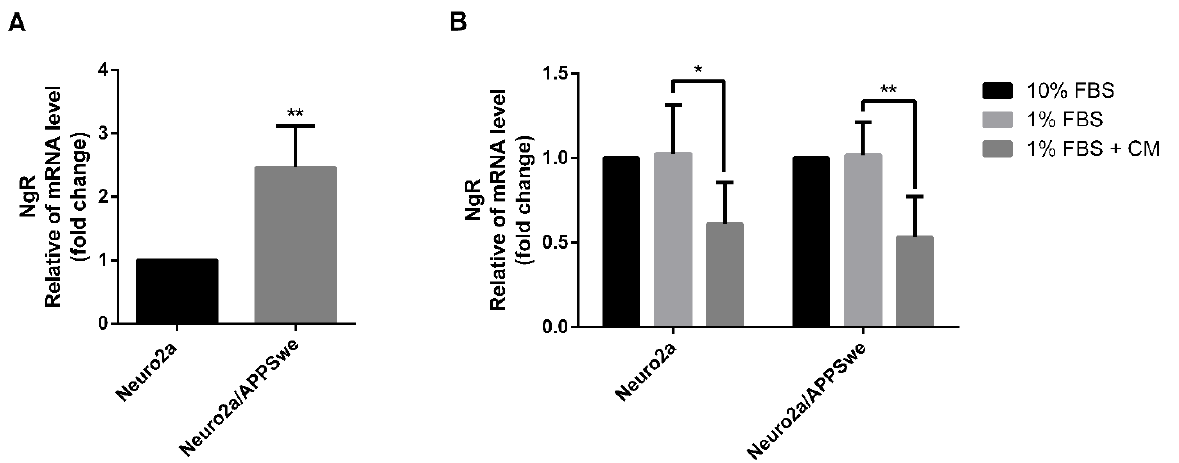
Figure 8. NgR mRNA expression level. ( A ) Neuro2a/APPSwe cells showed significant higher NgR gene expression level than Neuro2a cells after 48 h of treatment in 1% FBS medium. ( B ) NgR mRNA level between treatment groups of Neuro2a and Neuro2a/APPSwe cells was normalized vs. 10% FBS group for each cell type. NgR gene expression level in both Neuro2a and Neuro2a/APPSwe cells significantly decreased upon treatment with 10 µg/mL of CM extract for 48 h compared to 1% FBS treatment in each cell type. Values are mean ± SD of at least three independent experiments. * p -value < 0.05, ** p -value < 0.01.